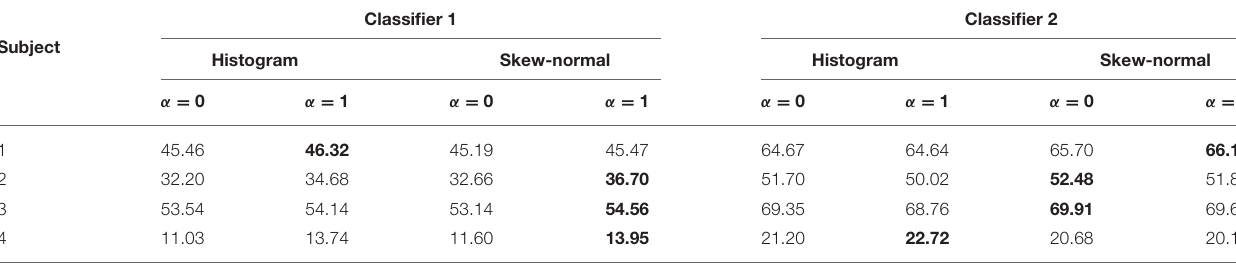
TABLE 3 | ITRs (6) of Classifier 1 and 2 resulting from 5-fold